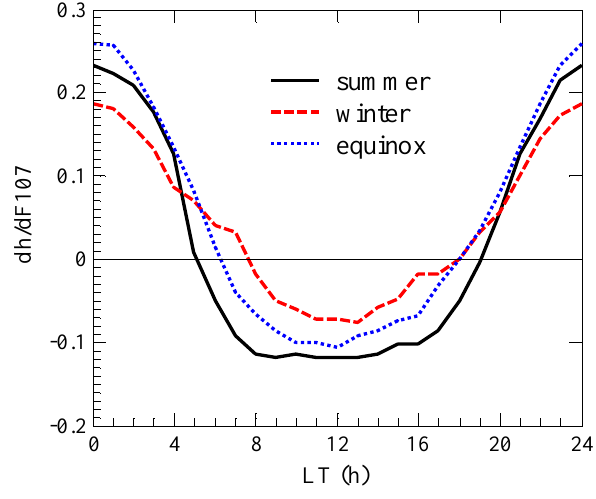
Figure 8. Variations of the gradient d h/ d F107, which is the slope of a linear regression of transition height LTH to solar activity F107 values at equinox, summer and winter.